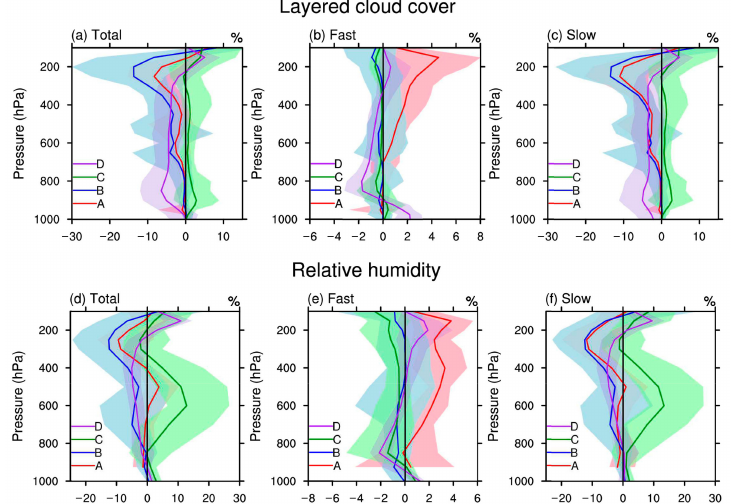
Figure 11. ( a , d ) Total, ( b , e ) fast, and ( c , f ) slow responses of ( a – c ) layered cloud cover (unit: %) and ( d – f ) relative humidity (unit: %) in four typical regions. The red, blue, green, and purple lines represent regions A, B, C, and D, respectively.